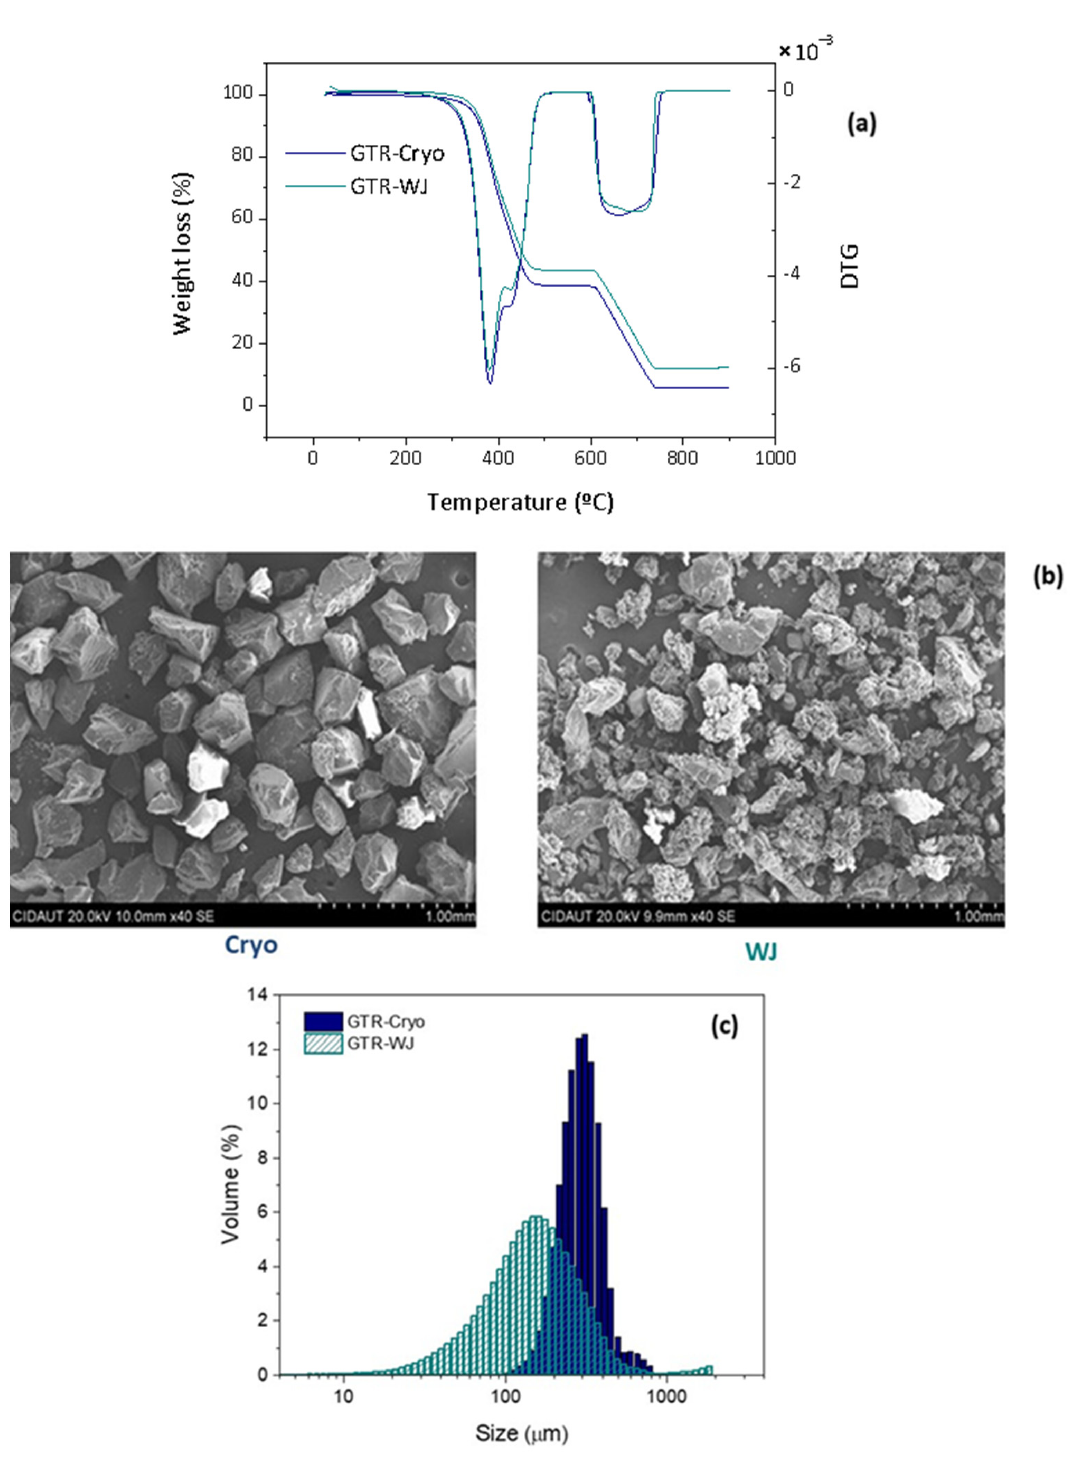
Figure 1. ( a ) DTG curves, ( b ) SEM micrographs, and ( c ) particle size distribution of the GTR obtained with cryogenic and water jet technologies.